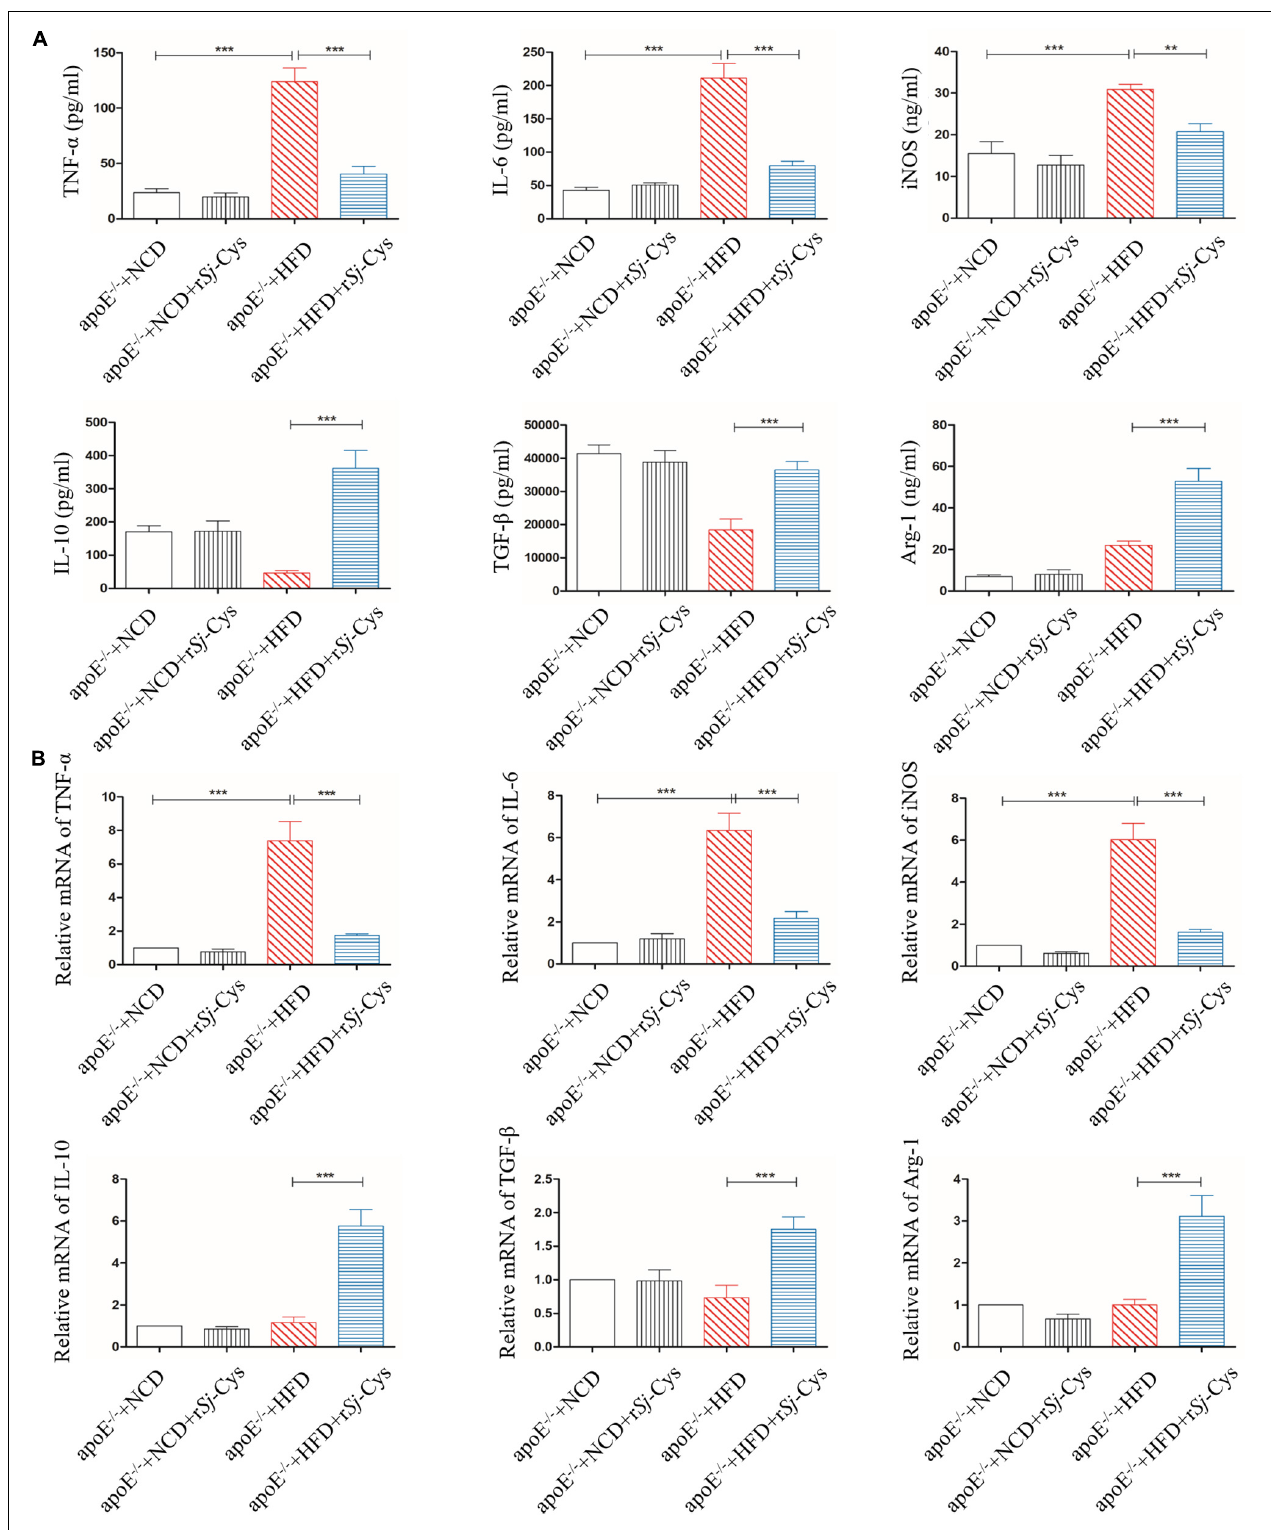
FIGURE 9 | r Sj -Cys inhibited proinflammatory cytokines (TNF- α and IL-6) and iNOS and induced immunomodulatory cytokines (IL-10 and TGF- β ) and Arg-1 in sera (A) and the similar mRNA expression pattern observed in renal tissues relative to the level of mice with NCD (B) . The data are shown as the mean ± SE for each group ( n = 6 per group). ** P < 0.01, *** P < 0.001.